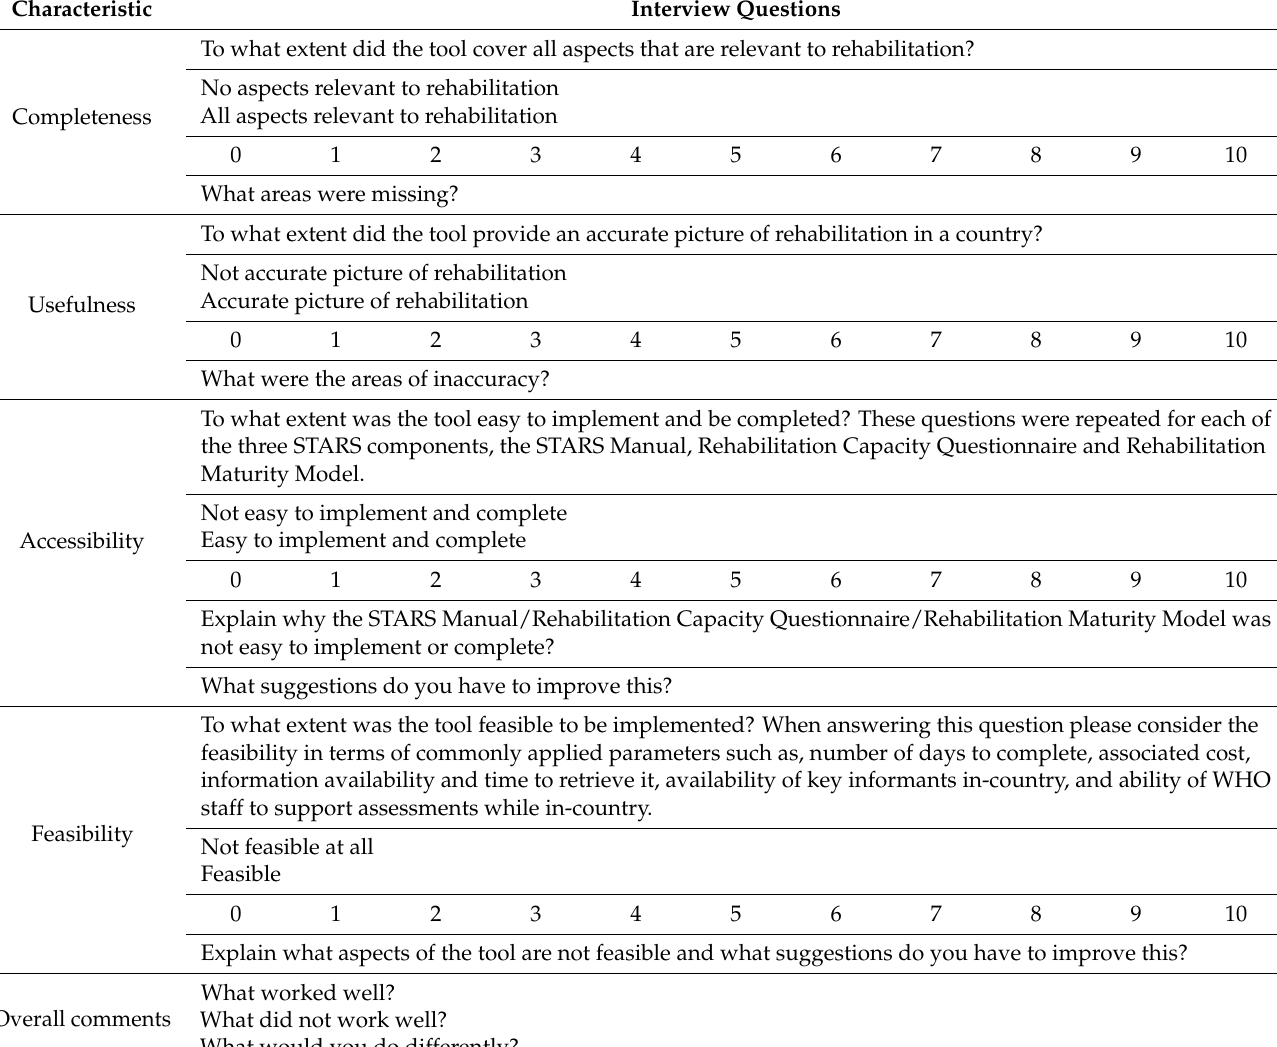
Table 1. Key Informant Interview questions for examination of completeness, usefulness, accessibility and the feasibility of STARS.